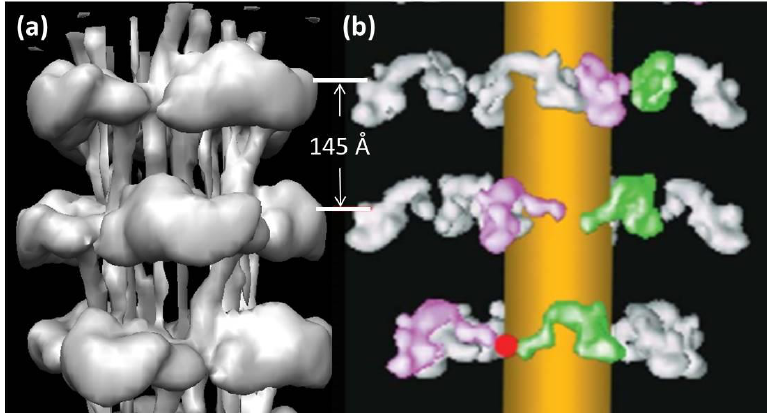
Figure 10. Comparison of three crown levels of the Hu et al. [27] insect flight muscle myosin filament density map ( a ) and the model ( b ) from AL-Khayat et al. [11] based on fitting X-ray diffraction data.